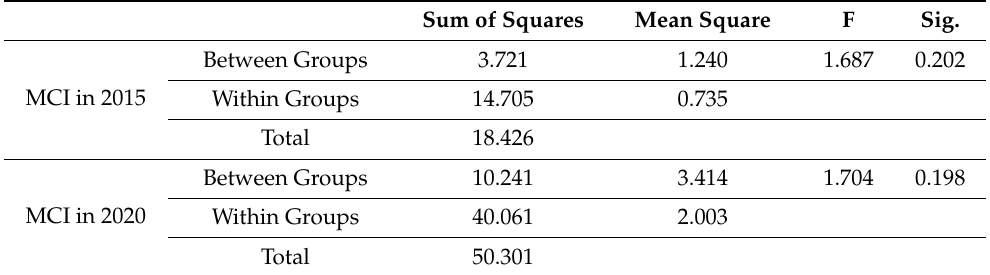
Table 7. ANOVA results of MCI and MCD among park green spaces of different scales. Sum of Squares Mean Square F Sig.